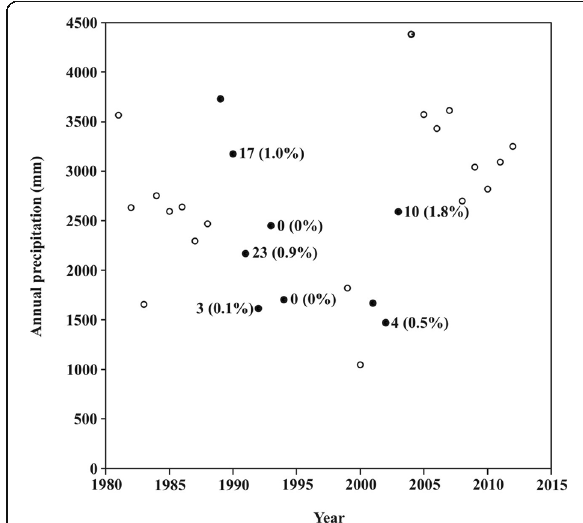
Fig. 1 Annual precipitation per year. Dots ( (cid:129) ) indicate data used in the analysis (including the lagged values), and data represented by circles ( ○ ) are presented to show longer-term trends in precipitation. The numbers of trees that died (and the corresponding percentage in parentheses) are shown for the year in which they died